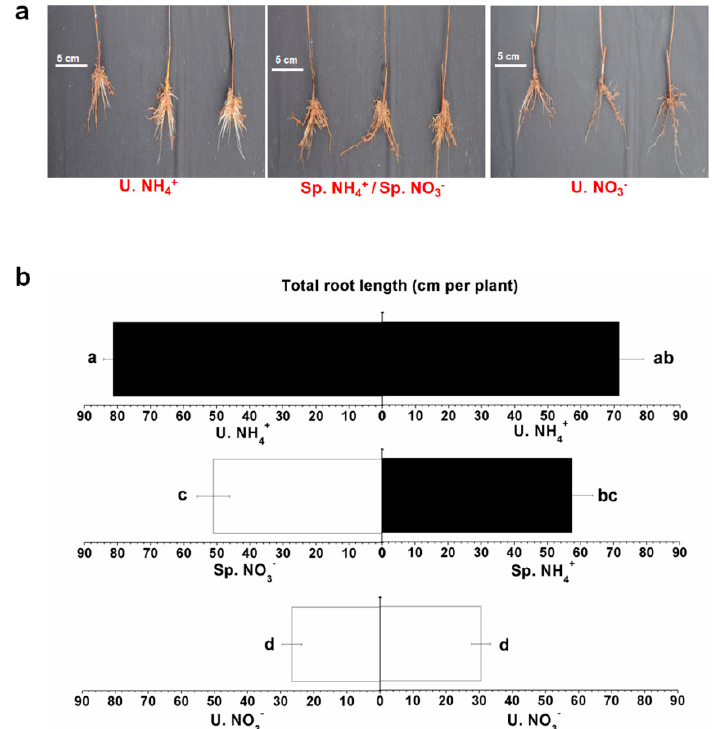
Figure 3. Root developments under the spatial heterogeneity of different N forms. ( a ) The root phenotypes of different treatments and ( b ) the total root length of different treatments. The mean ± SE ( n = 3) are shown in the data. The different letters show that means are significantly different at p < 0.05. The different conditions to compare the analytical results obtained are shown in the Materials and Methods section.